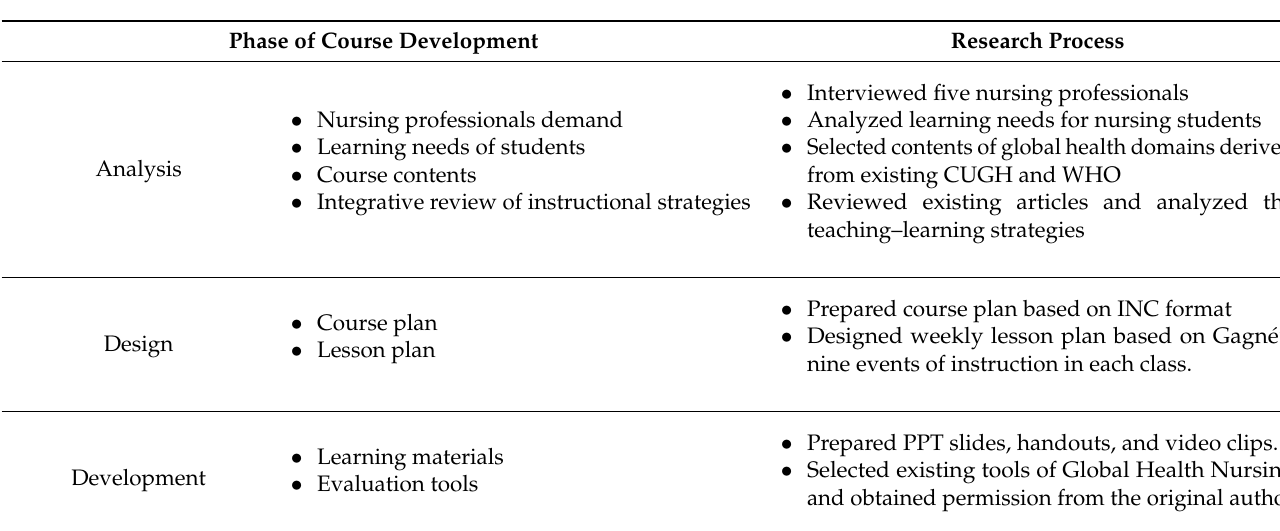
Figure 1. Methodological framework based on ADDIE model. Table 1. Development of the Course on Global Health